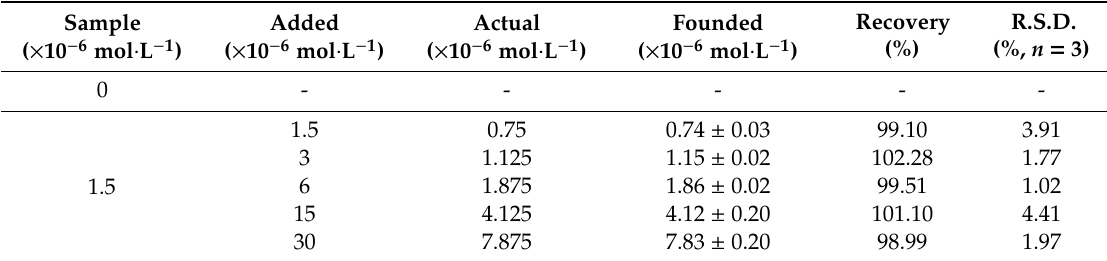
Table 3. Detection of difenidol hydrochloride in real samples and their